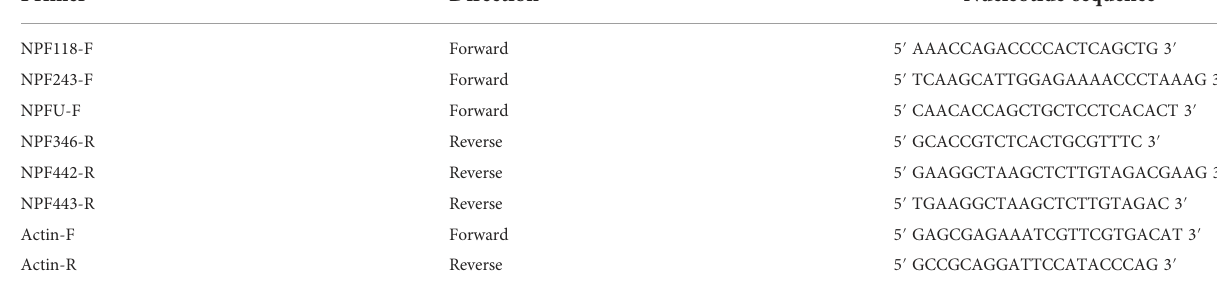
TABLE 1 Primers used for molecular cloning and